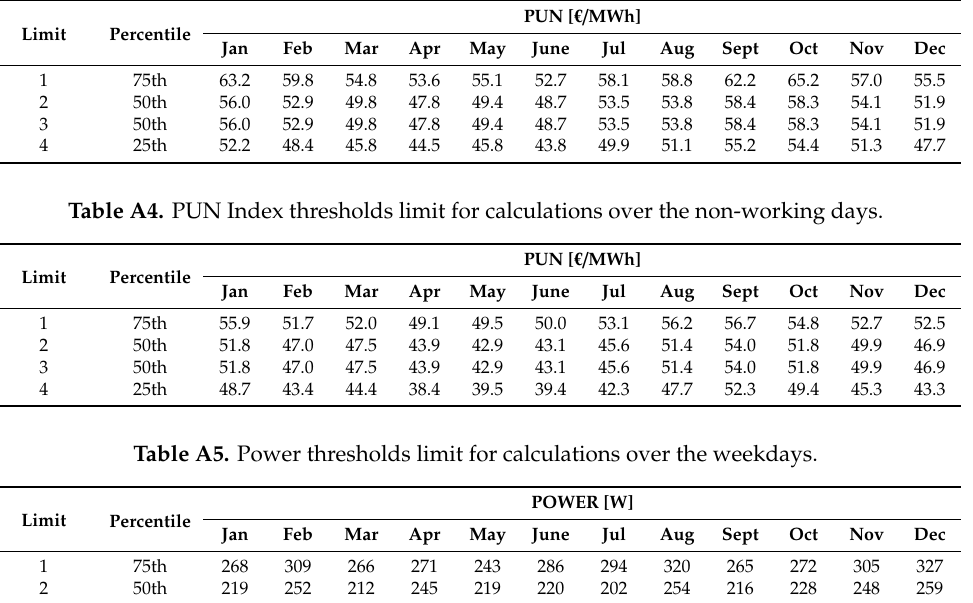
Table A3. PUN Index thresholds limit for calculations over the Saturdays.